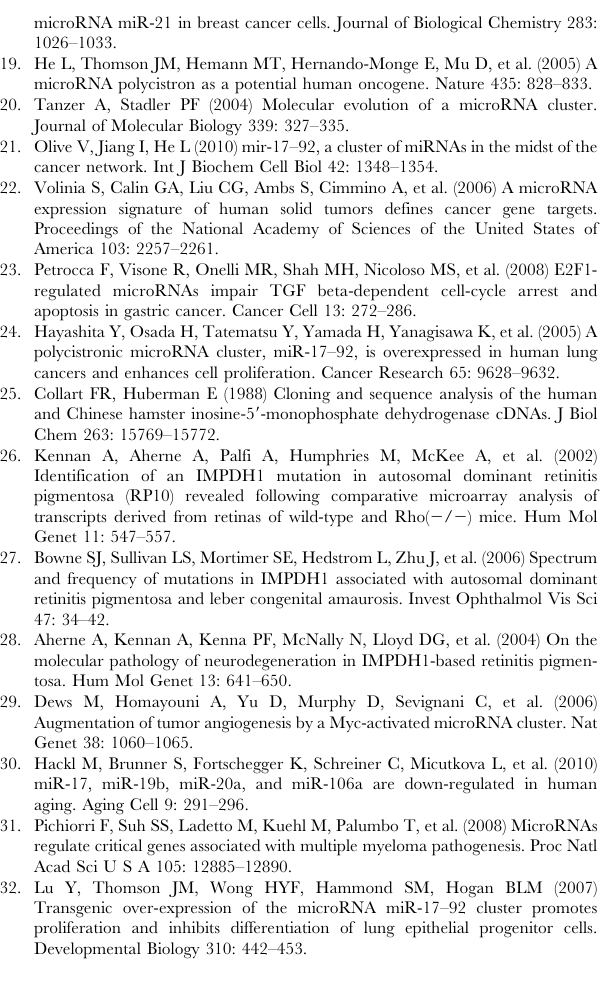
Figure S1 A representative gel image of MCF-7 cells treated with the anti-miRNA-LNA after fluorescent staining. Protein spots indicated with red circles were positive candidates for regulation by miR-17–92. The molecular weight marker is indicated at left. Figure S2 A representative enlarged gel image and spots of candidate targets. The protein spots indicated by arrowheads are target spots on the gels. Figure S3 The MS/MS spectra used to identify candi- date proteins. The panels show the MS/MS spectra of representative peptides; (A) Serine/threonine-protein phosphatase 2A 55 kDa regulatory subunit B alpha isoform (PPP2R2A), (B)